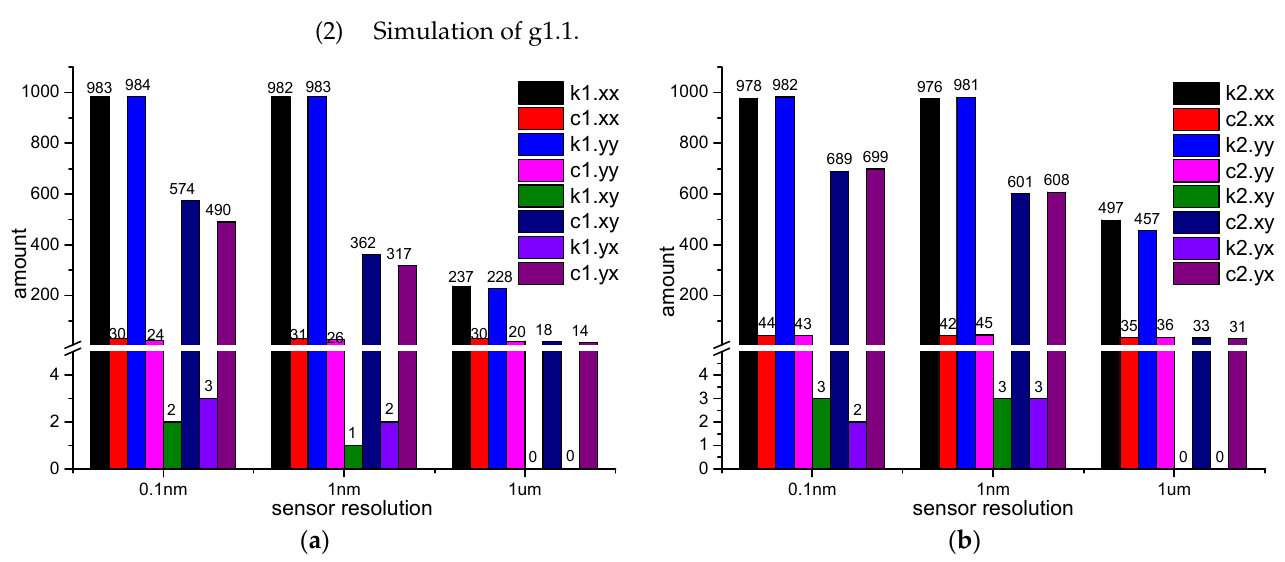
Figure A10. Statistical results of the amount of the frequencies, at which the related error is less than 10% and the absolute value is less than 10: ( a ) #1 bearing; ( b ) #2 bearing.